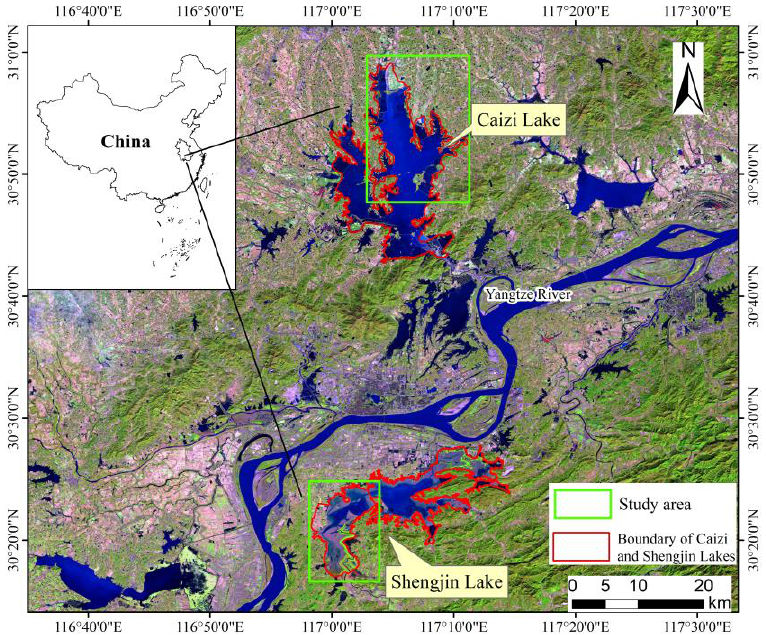
Figure 1. Location of the study area at Shengjin and Caizi Lakes.